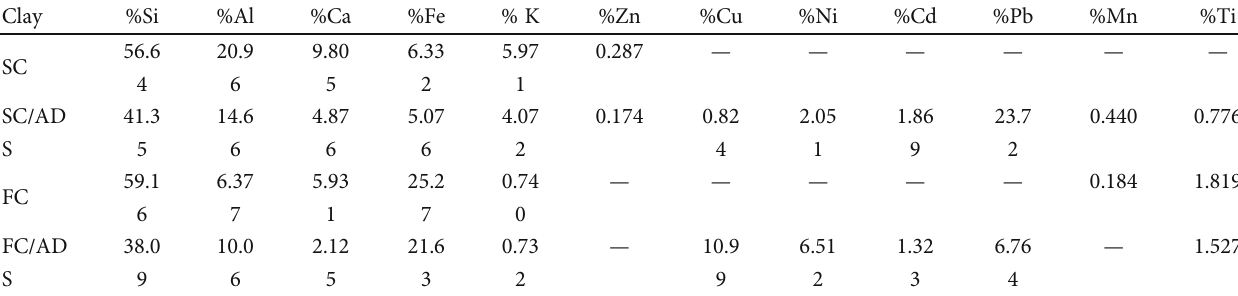
Table 1: Chemical composition (% by weight) obtained for X-ray fl